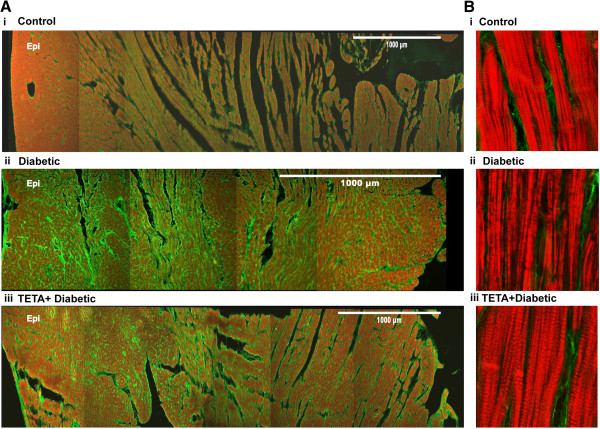
Confocal sections of LV free wall. Confocal microscopy was used to image fluorescent antibody labels to identify type I & type III collagen, and phalloidin-rhodamine labelled F-actin in sections (30 μm) from the LV free wall. (A) Shows representative LV wall cross-sections (16 х objective) labelled for F-actin (red) and type I collagen (green) in control (i), diabetic (ii) and TETA-treated diabetic rats (iii) (n = 7/group). Diabetic rats had decreased LV wall thickness and increased collagen labelling compared to controls; TETA-treatment normalized type I collagen labelling. (B) illustrates representative longitudinal sections of LV tissues (40 х objective, zoom 3) from control (i), diabetic (ii) and TETA-treated diabetic rats (iii). Diabetic rats displayed disrupted F-actin structure whereas TETA-treatment maintained F-actin integrity.